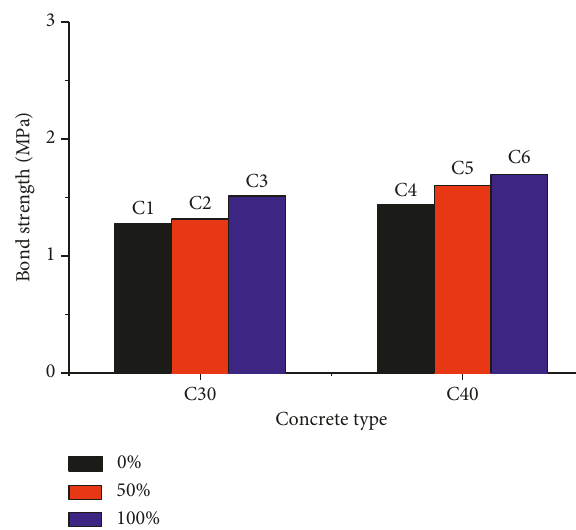
Figure 10: Effect of concrete strength on bond strength.